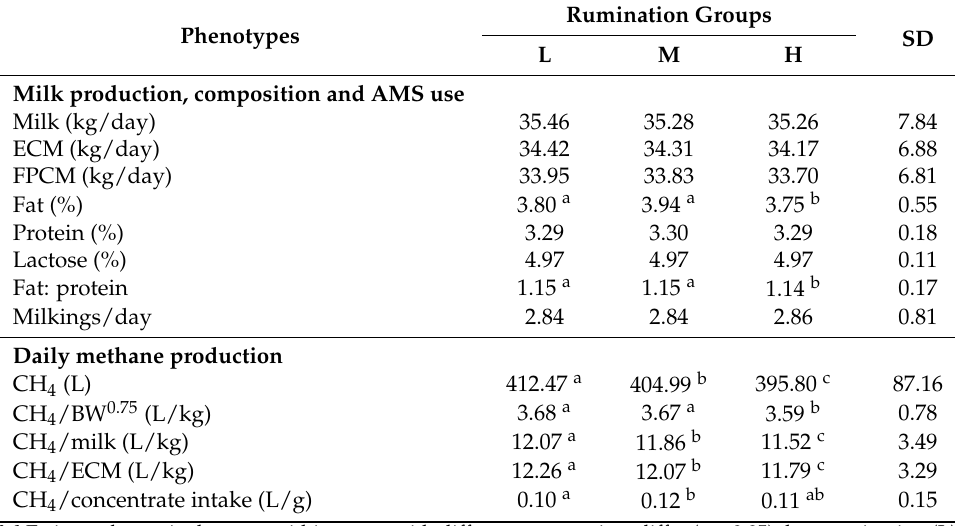
Table 3. Estimated marginal means for milk and methane production phenotypes of low (L), medium (M), and high (H) rumination